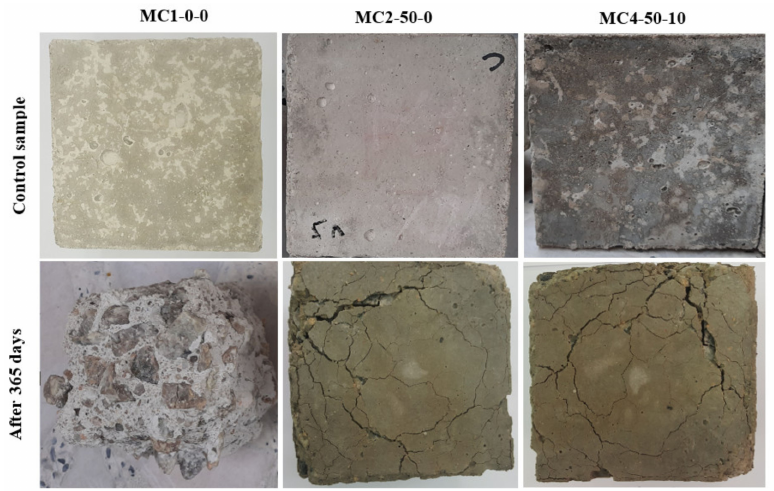
Figure 13. Visual appearance of modified concrete exposed H 2 SO 4 after 365 days of immersion